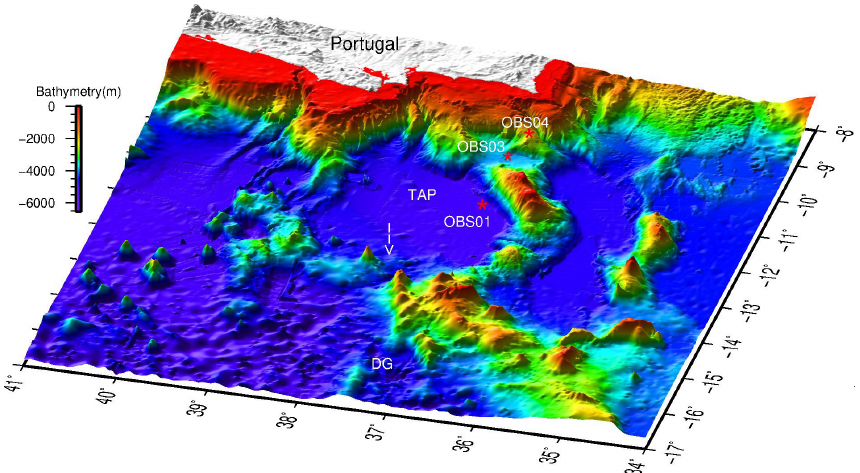
Figure 4. 3D perspectives – location of 9H OBS01, OBS03 and OBS04 in SW Iberia with the local seafloor topography. Portugal is repre- sented as white. The Discovery Gap (DG) is the main gate for the Antarctic Bottom Water (AABW), and the white arrow points out to the main gate where the AABW enters the Tagus Abyssal Plain (TAP).